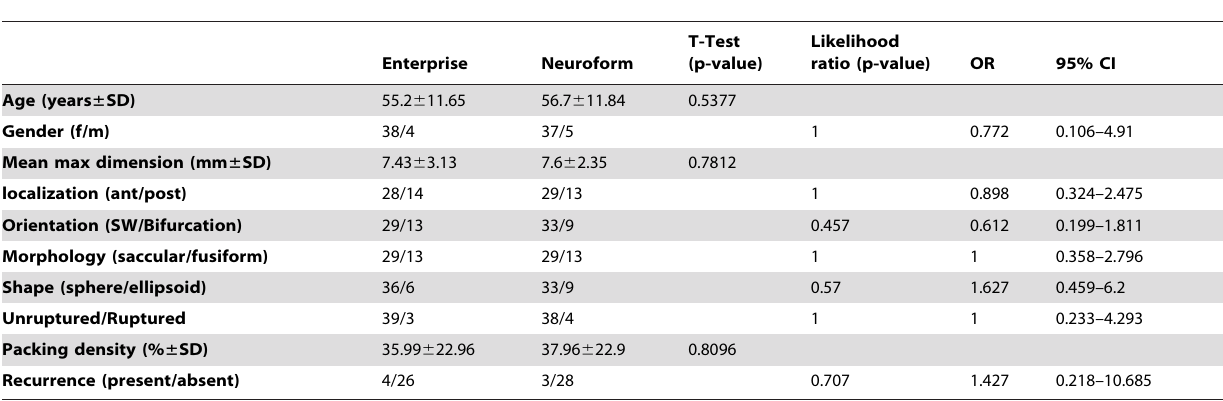
Table 1. Baseline Demographics of aneurysms treated by stent-assisted coiling using the Enterprise or Neuroform stent.